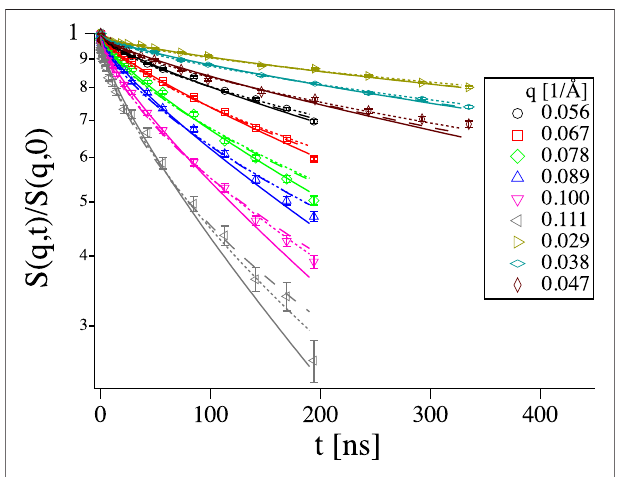
FIGURE 5 | Γ Z G obtained from fi tting Eq. 1 (black circles) and Eq. 7 (red squares) to the vesicle data. Including diffusion leads to systematically lower